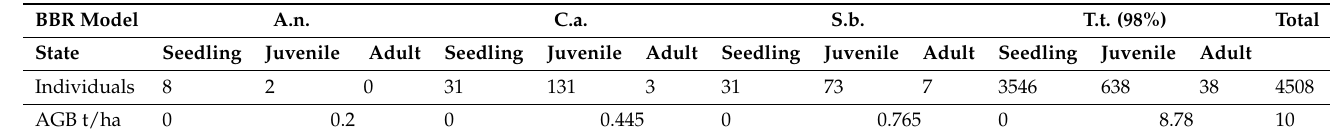
Table 3. Tree initialization in the BBR Model.